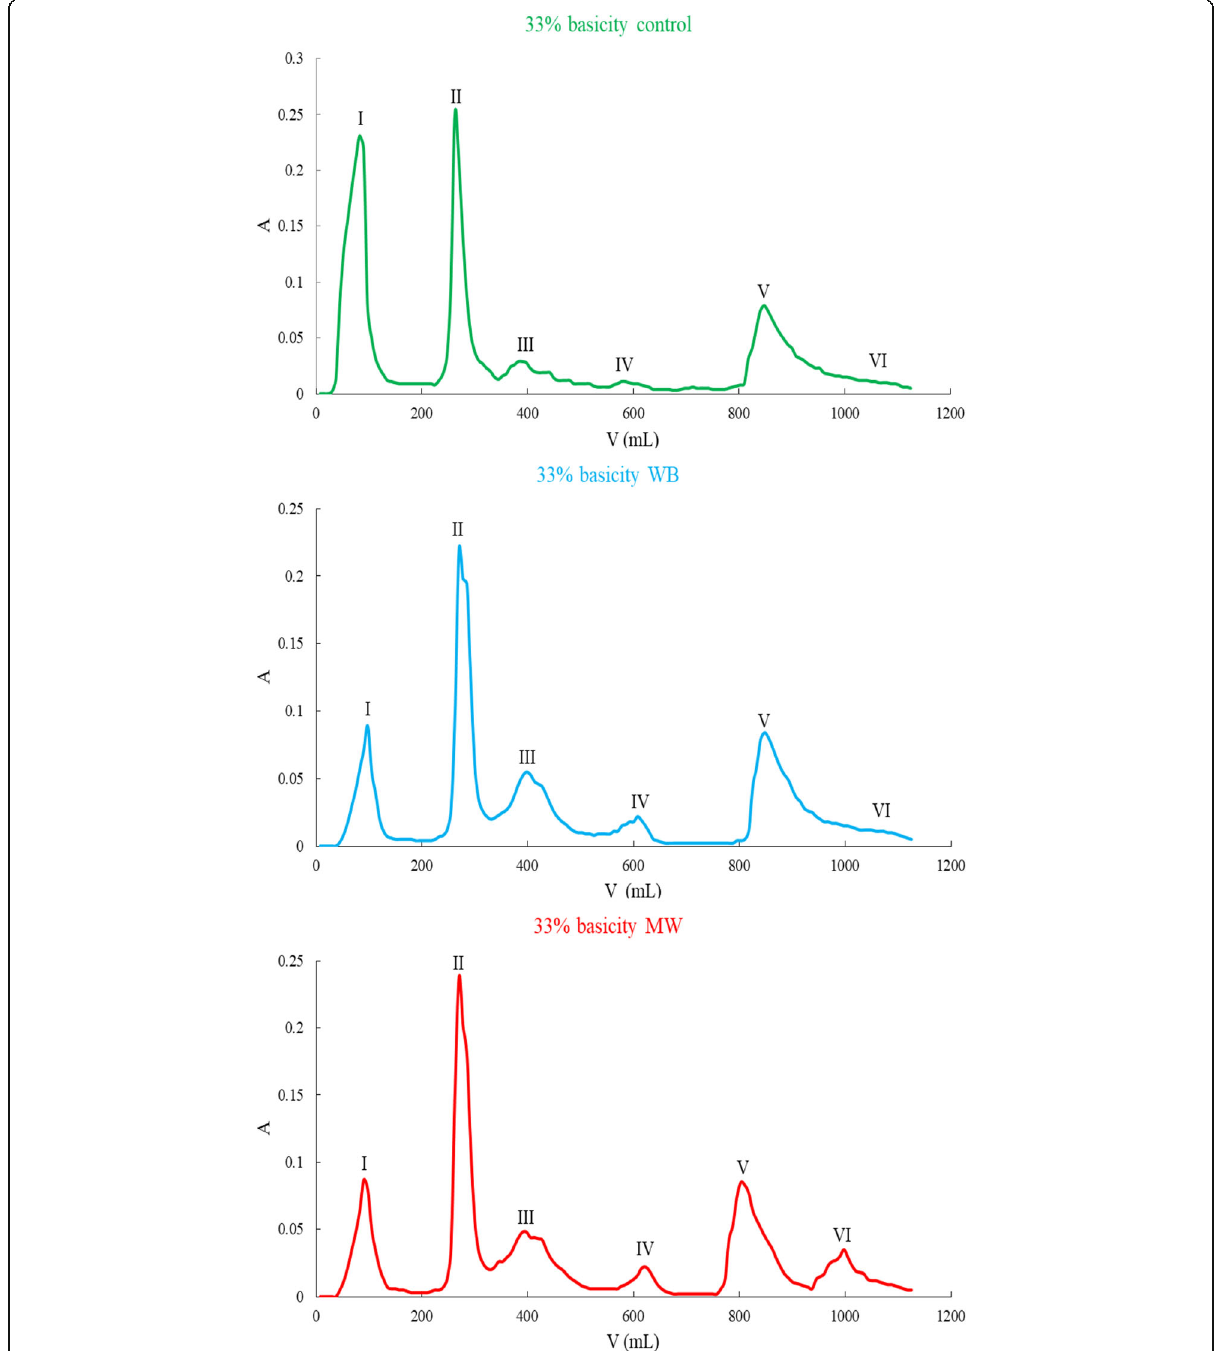
Fig. 2 The IEC results of 33% basicity chromium sulphate tanning liquors warmed under different